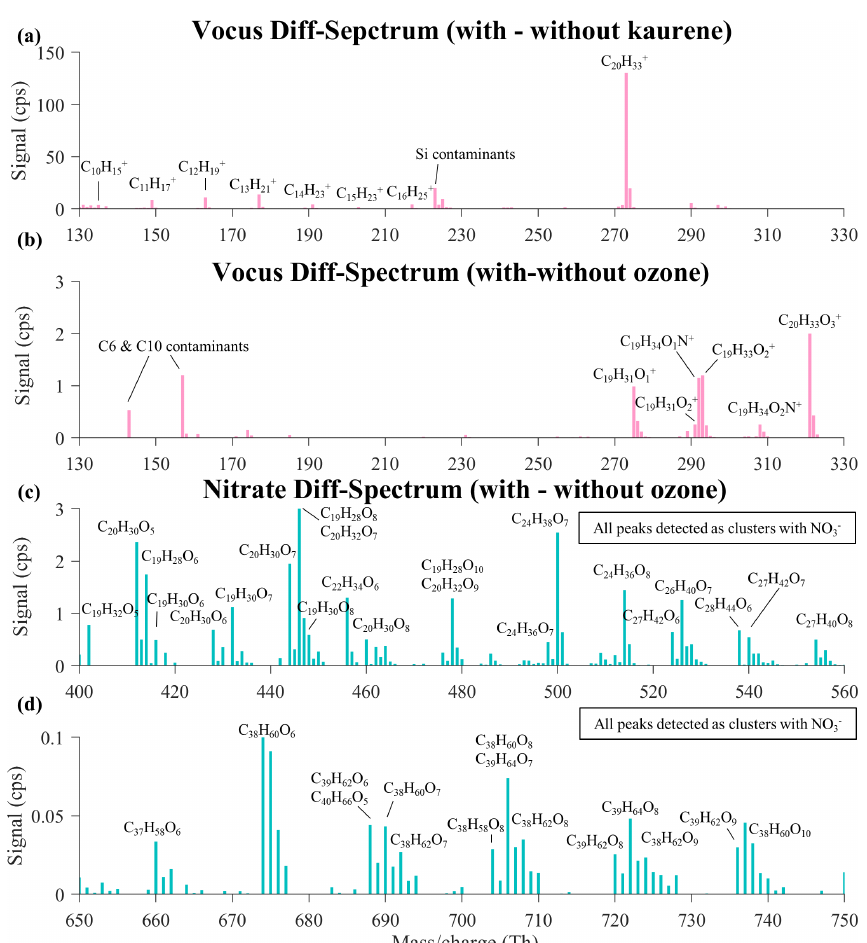
Figure 4. Background-subtracted (diff) spectra of kaurene and kaurene oxidation products. The spectrum in (a) shows the difference between the Vocus spectra before and after kaurene injection; the spectrum in (b) displays the change of Vocus spectrum before and after O 3 was injected into the chamber with kaurene. Comparison of nitrate CI-APi-TOF spectra before and after O 3 injection into the kaurene-existing chamber is shown in (c) and (d) . The compounds in (a) and (b) are labeled as what they were actually detected by Vocus, whereas all peaks labeled in (c) and (d) are detected as a cluster with NO − 3